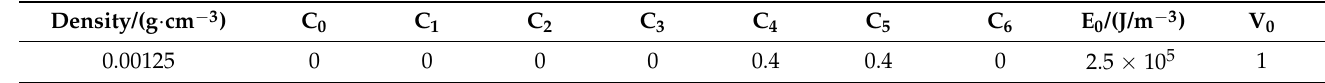
Table 4. Air material